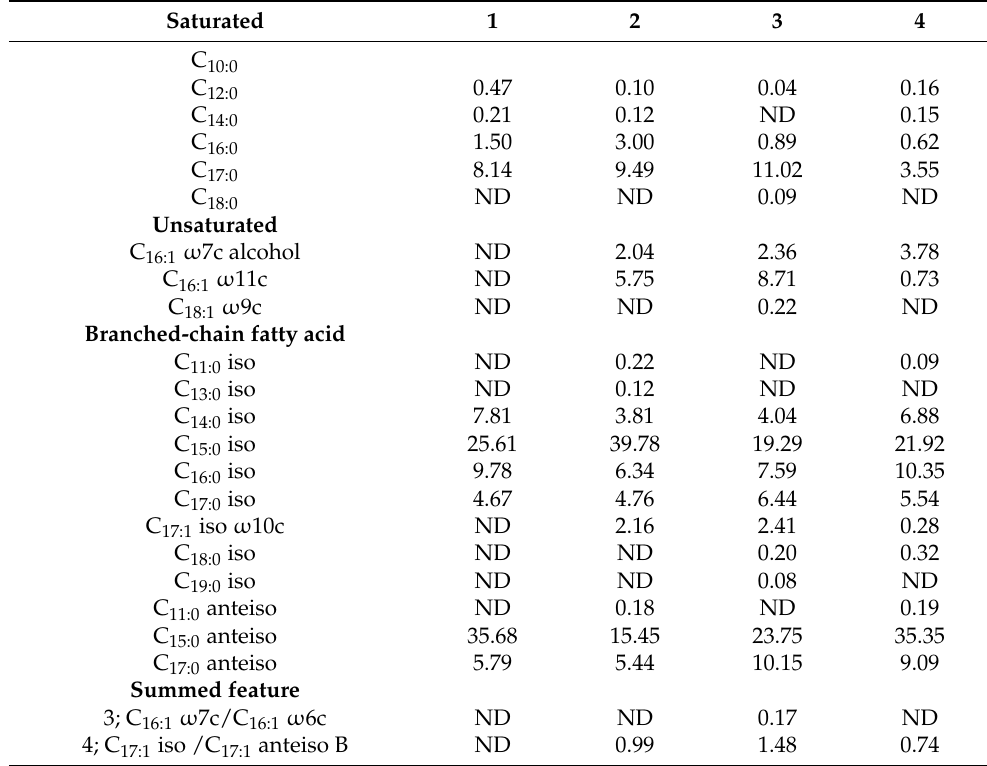
Table 2. Cellular fatty acid contents (>1% of the total fatty acids) of strain KIGAM252 T and related species. Taxa: 1, Strain KIGAM252 T ; 2, M. mangrovi AK61 T ; 3, M. indicus LMG 22858 T ; 4, M. idriensis SMC 4352-2 T . All data are from this study under the same condition.